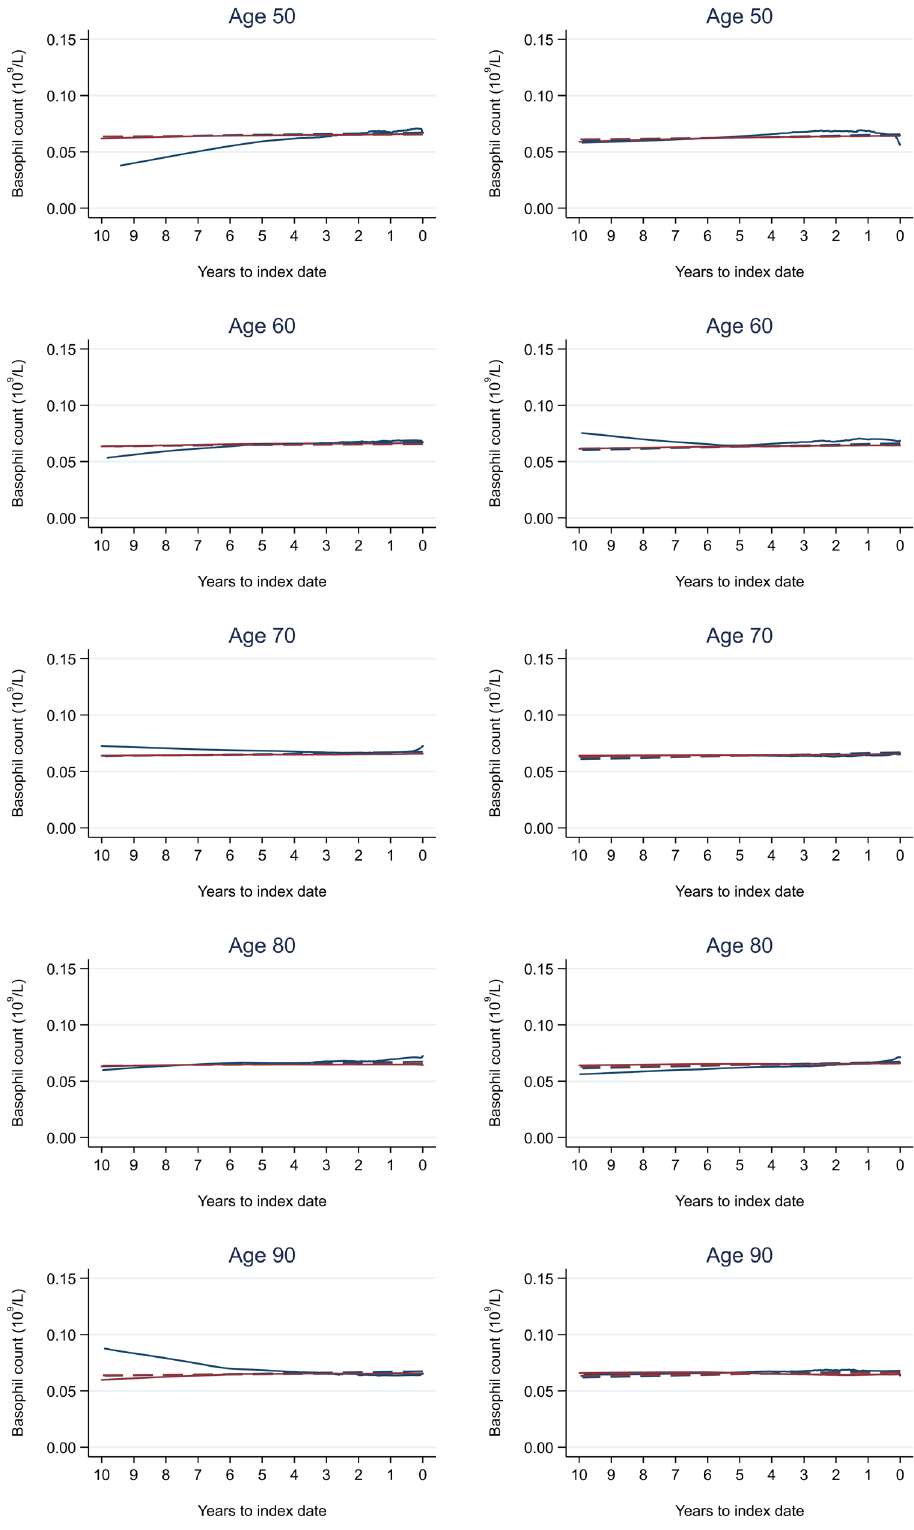
Figure 13. Basophil count trends between cases and controls, by age at index date 1,2 . 1 Index date was the date of diagnosis for cases and a randomly selected date in the patient’s study period for controls. 2 LOWESS trends are age (+/- 3 years) and modelled (fixed effects) trends are taken at that specific age. Legend: males (left) and females (right). Colorectal cancer (blue line) and no cancer (red line). LOWESS trend (solid line) and modelled trend (dashed line).